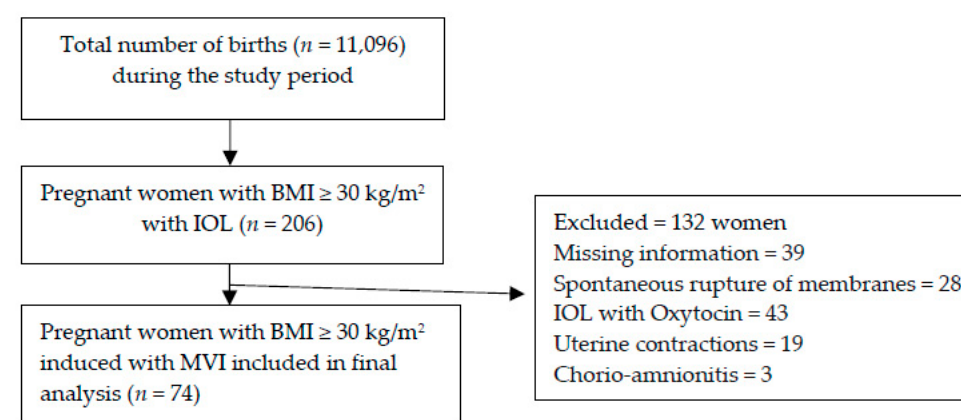
Figure 2. Flow-diagram of patient selection and distribution.